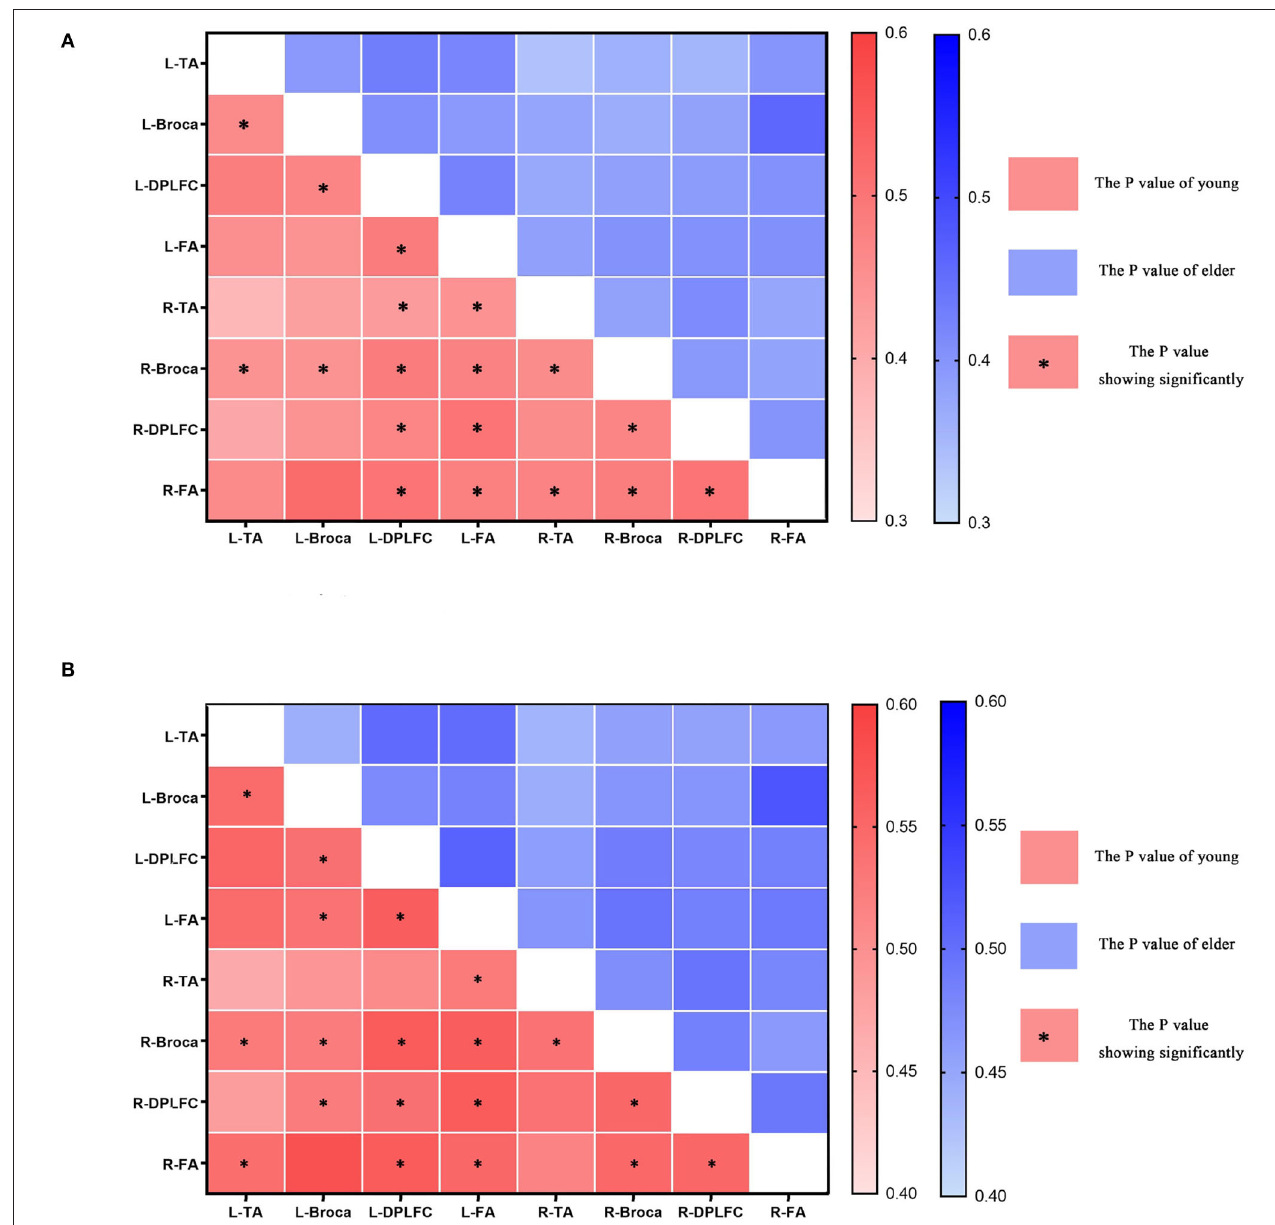
FIGURE 8 | The p- values of different brain areas in young and elder people, L-x = L corresponding brain areas, R-x = R corresponding brain areas, * in red box indicates significant enhancement in the connectivity of young. (A) The connectivity in interval III. (B) The connectivity in interval IV.